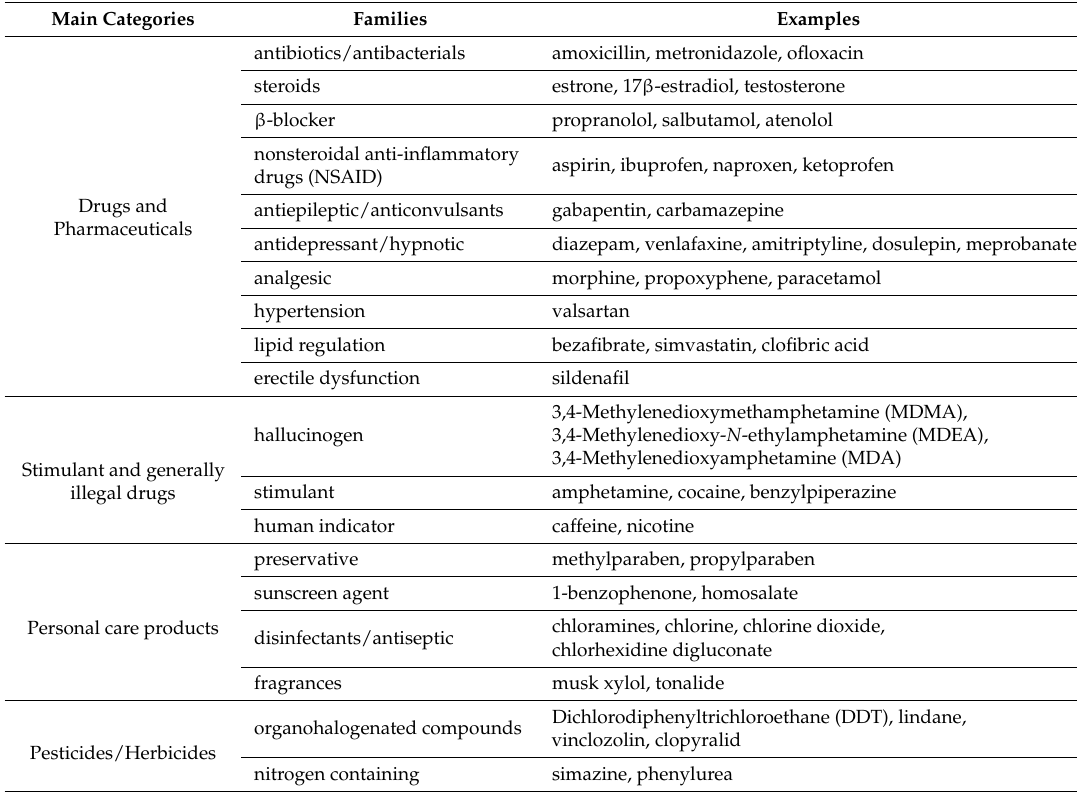
Table 1. Pharmaceuticals and personal care products (PPCPs) and emerging contaminants (ECs) commonly detected in water